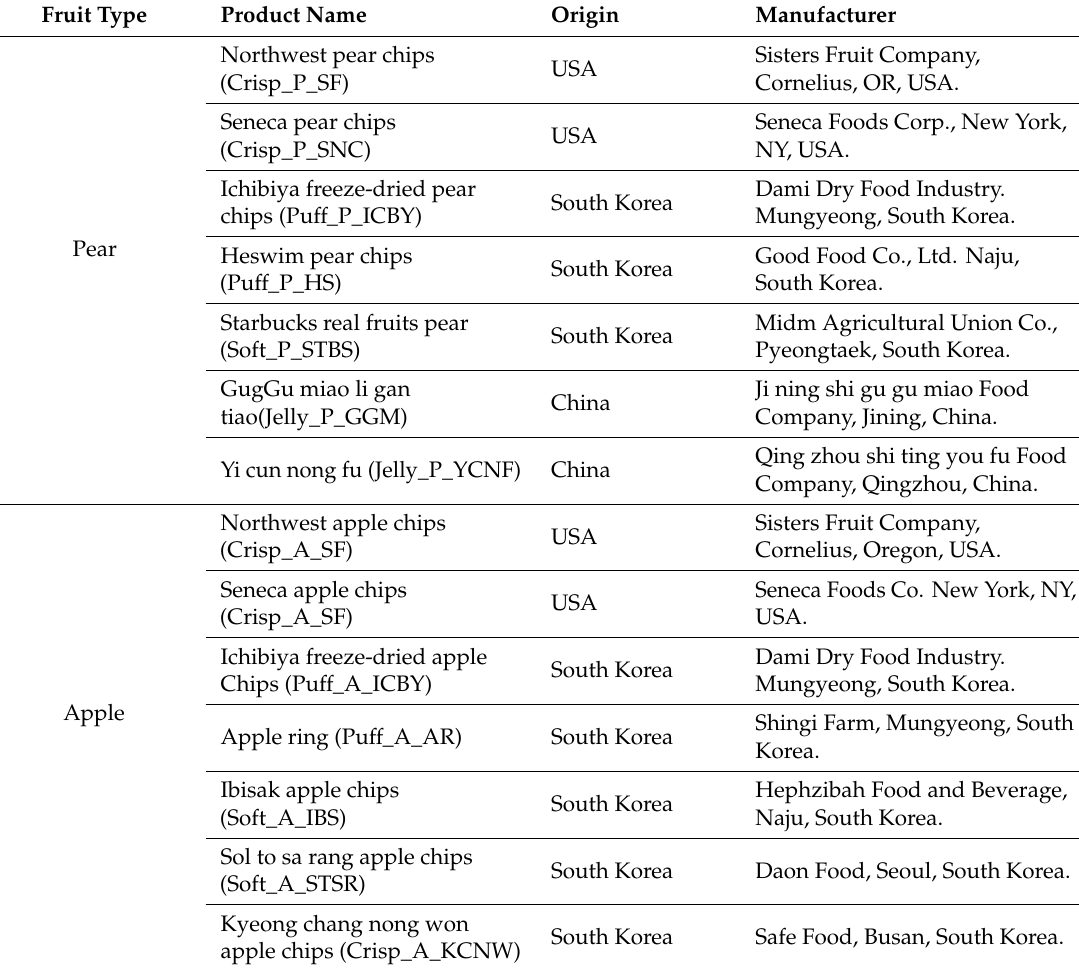
Table 1. Product information for the dried fruit